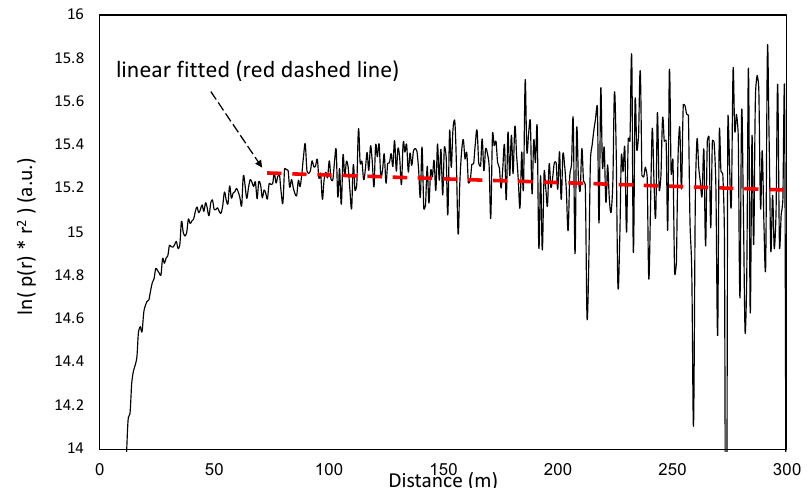
Figure 4. LED-lidar echo waveform after range compensation.